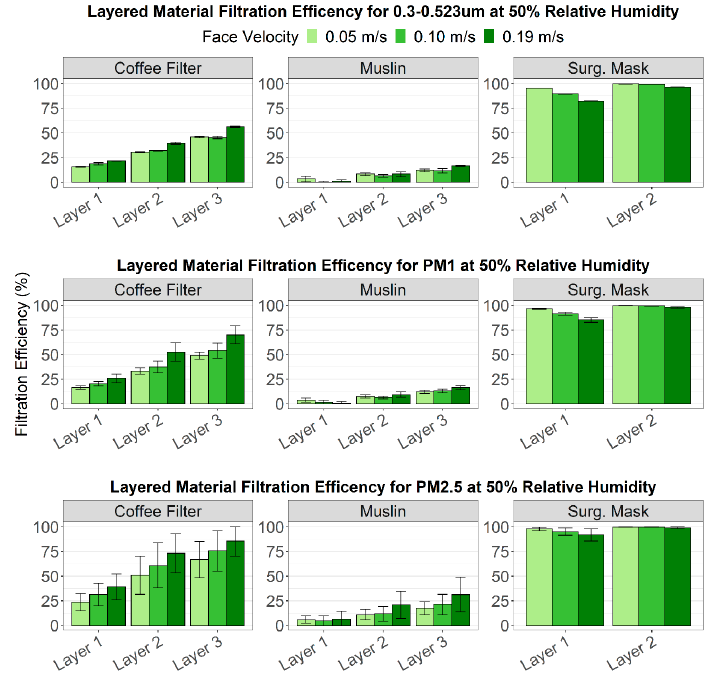
Figure 6. FE results for layered materials as a function of face velocity. Bar colors represent the corresponding face velocity values; the results are plotted at the average FE from three measurements, with the error bars representing the standard deviation.